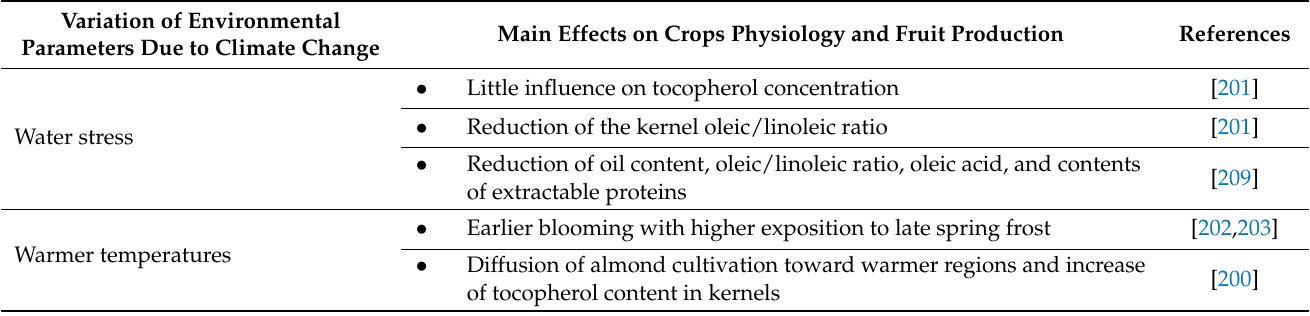
Table 8. Summary of principal effects of environmental conditions variation on almond